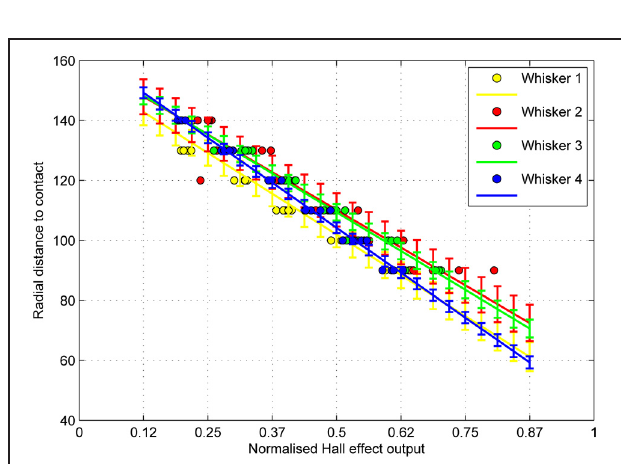
FIGURE 10 | Radial distance to contact affects deflection magnitude on the mobile CrunchBot robot. Five deflections at different radial distances (R, in mm), but the same speed. Peak deflection height varies predictably with radial distance.